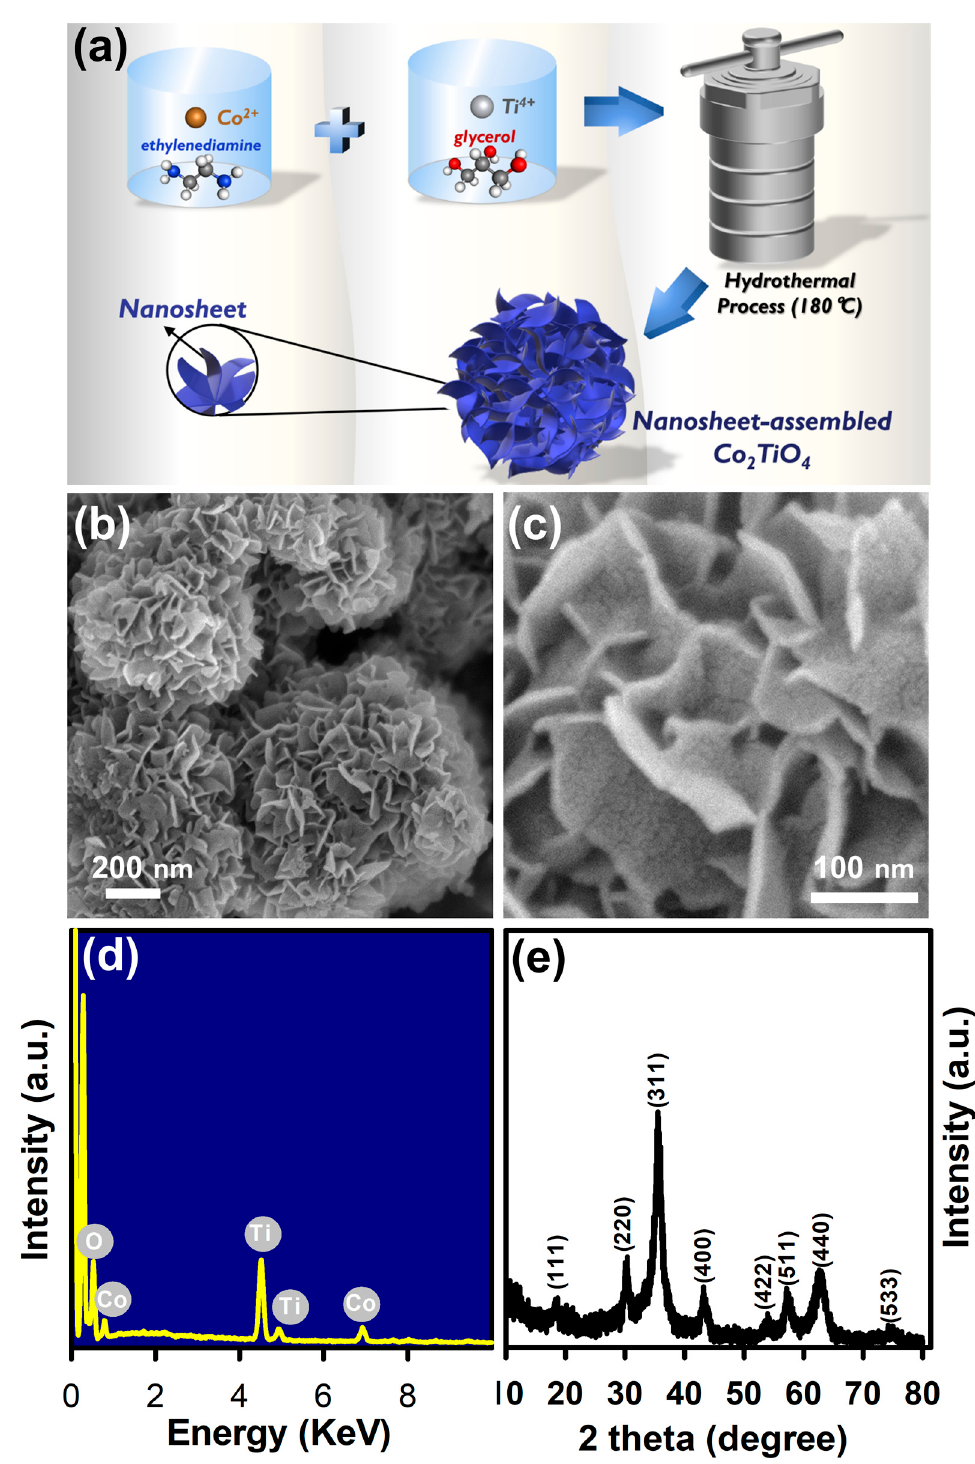
Figure 1. ( a ) Scheme of fabrication of CTO. Morphologies of CTO: ( b , c ) SEM images, ( d ) EDS, and ( e ) XRD pattern.